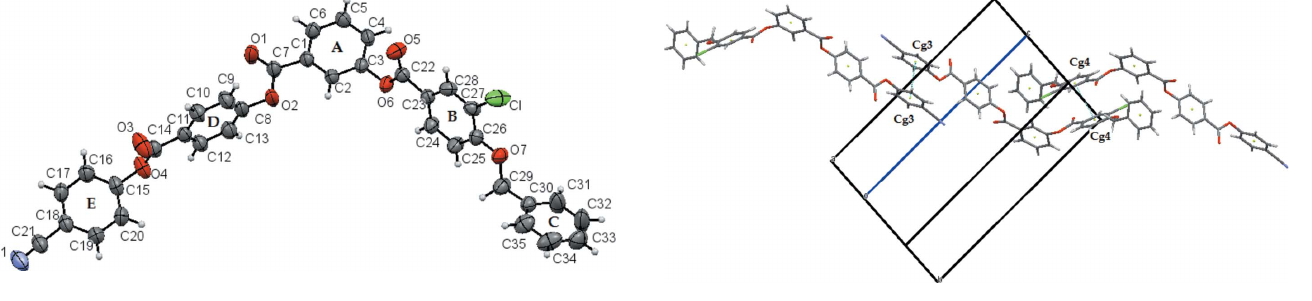
Figure 1 The molecular structure of the title compound, showing displacement ellipsoids drawn at the 50% probability